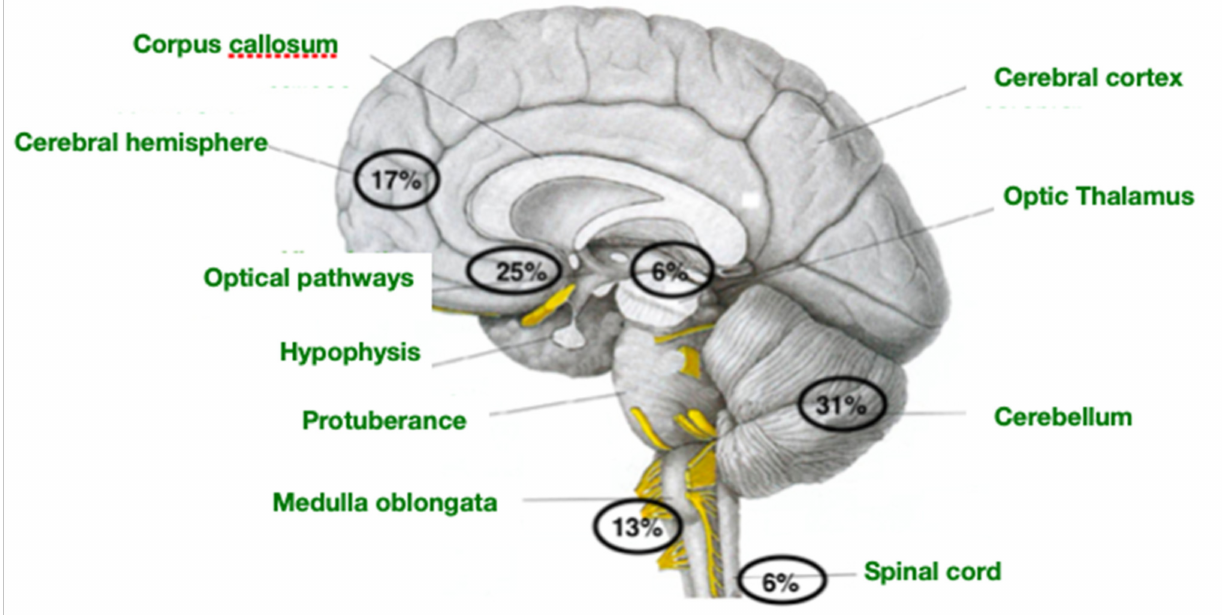
Figure 1. Most frequent location of low-grade